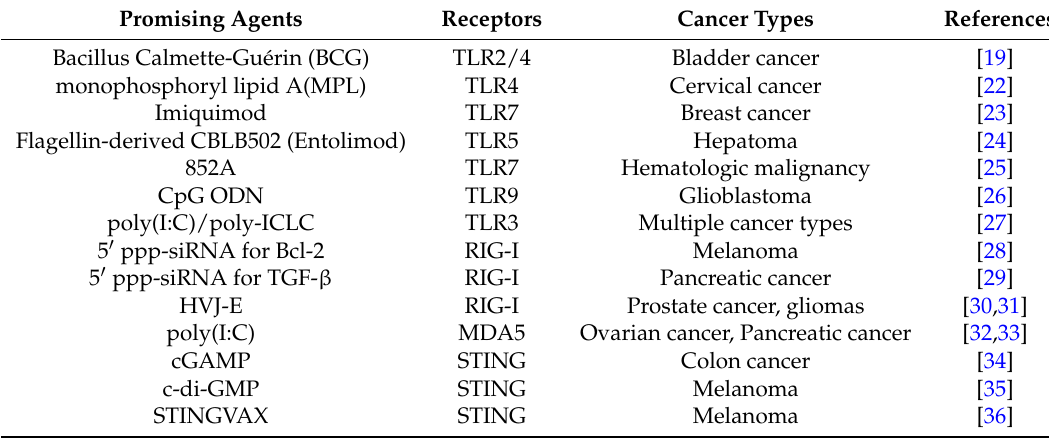
Table 1. Overview of promising agents that trigger the Toll-like receptors (TLR), RIG-I-like receptors (RLR) and stimulator of interferon gene (STING) pathway for cancer immunotherapy. Promising Agents Receptors Cancer